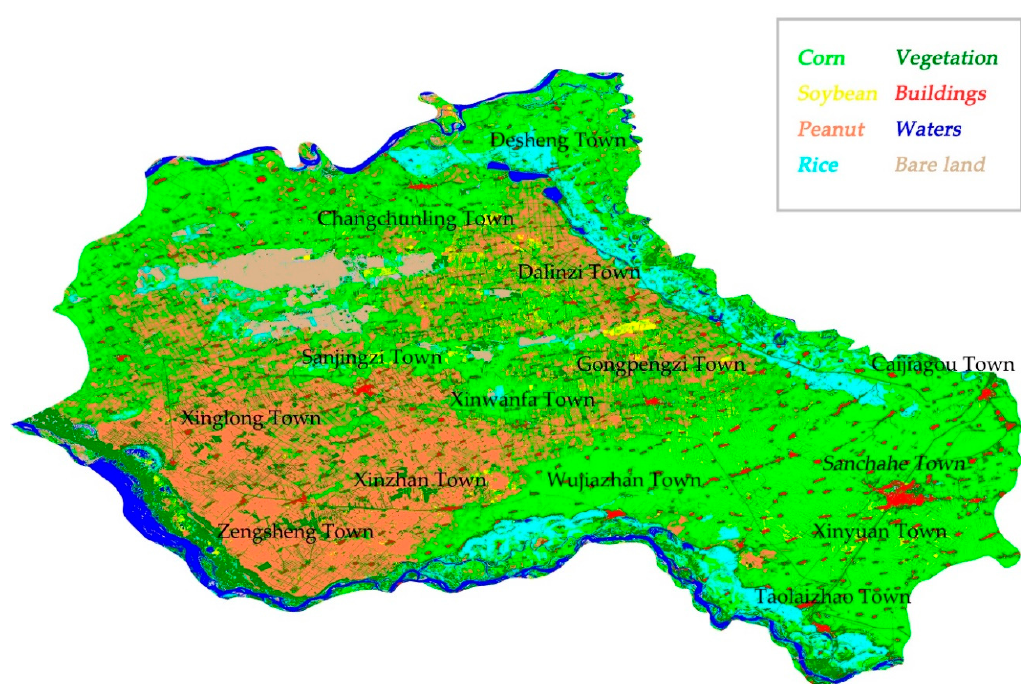
Figure 9. Crop mapping results of Fuyu City using the U-Net network.